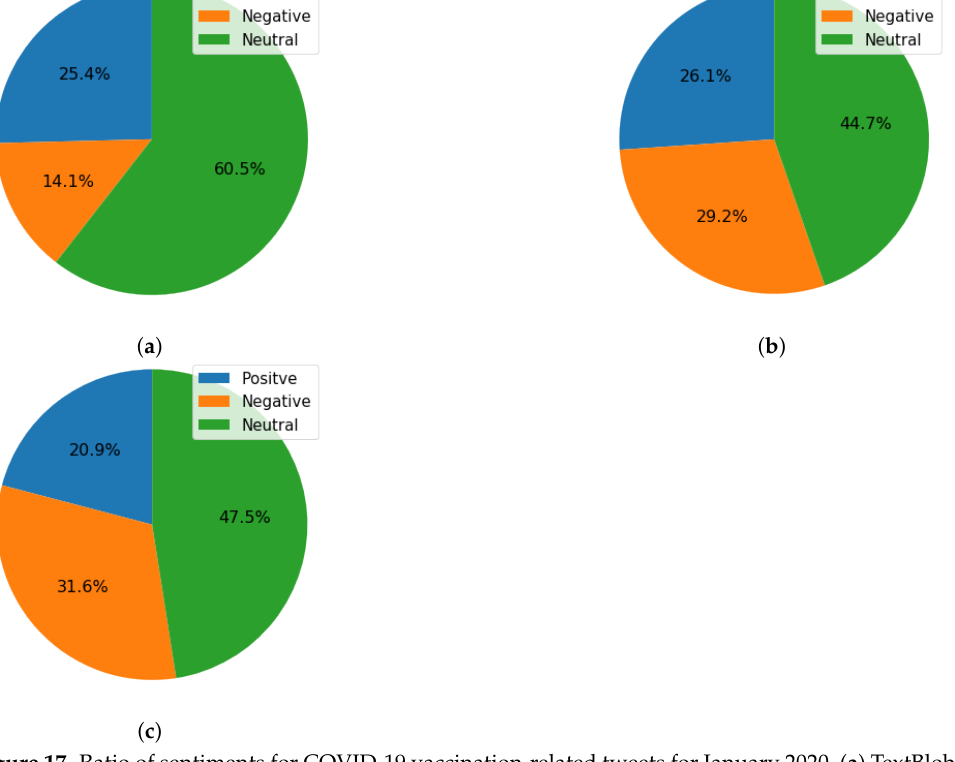
Figure 17. Ratio of sentiments for COVID-19 vaccination-related tweets for January 2020, ( a ) TextBlob sentiments, ( b ) VADER sentiments, and ( c ) AFINN sentiments.